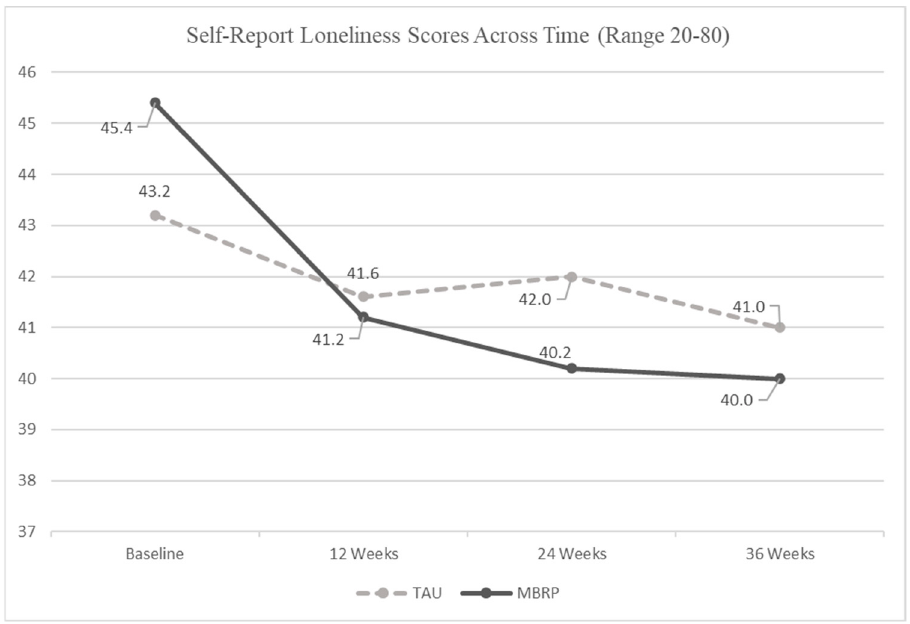
Figure 2. Self-Report Loneliness Scores by Group across the 36 Week Intervention from the Linear Mixed Model .